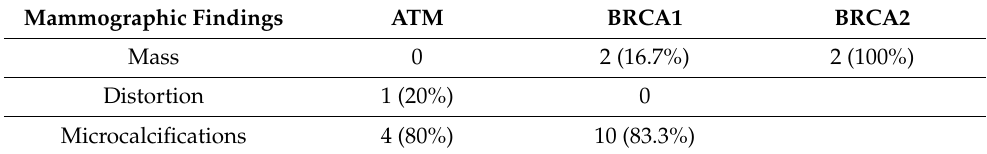
Table 3. Mammographic appearance of B3 lesions in the three groups of mutations